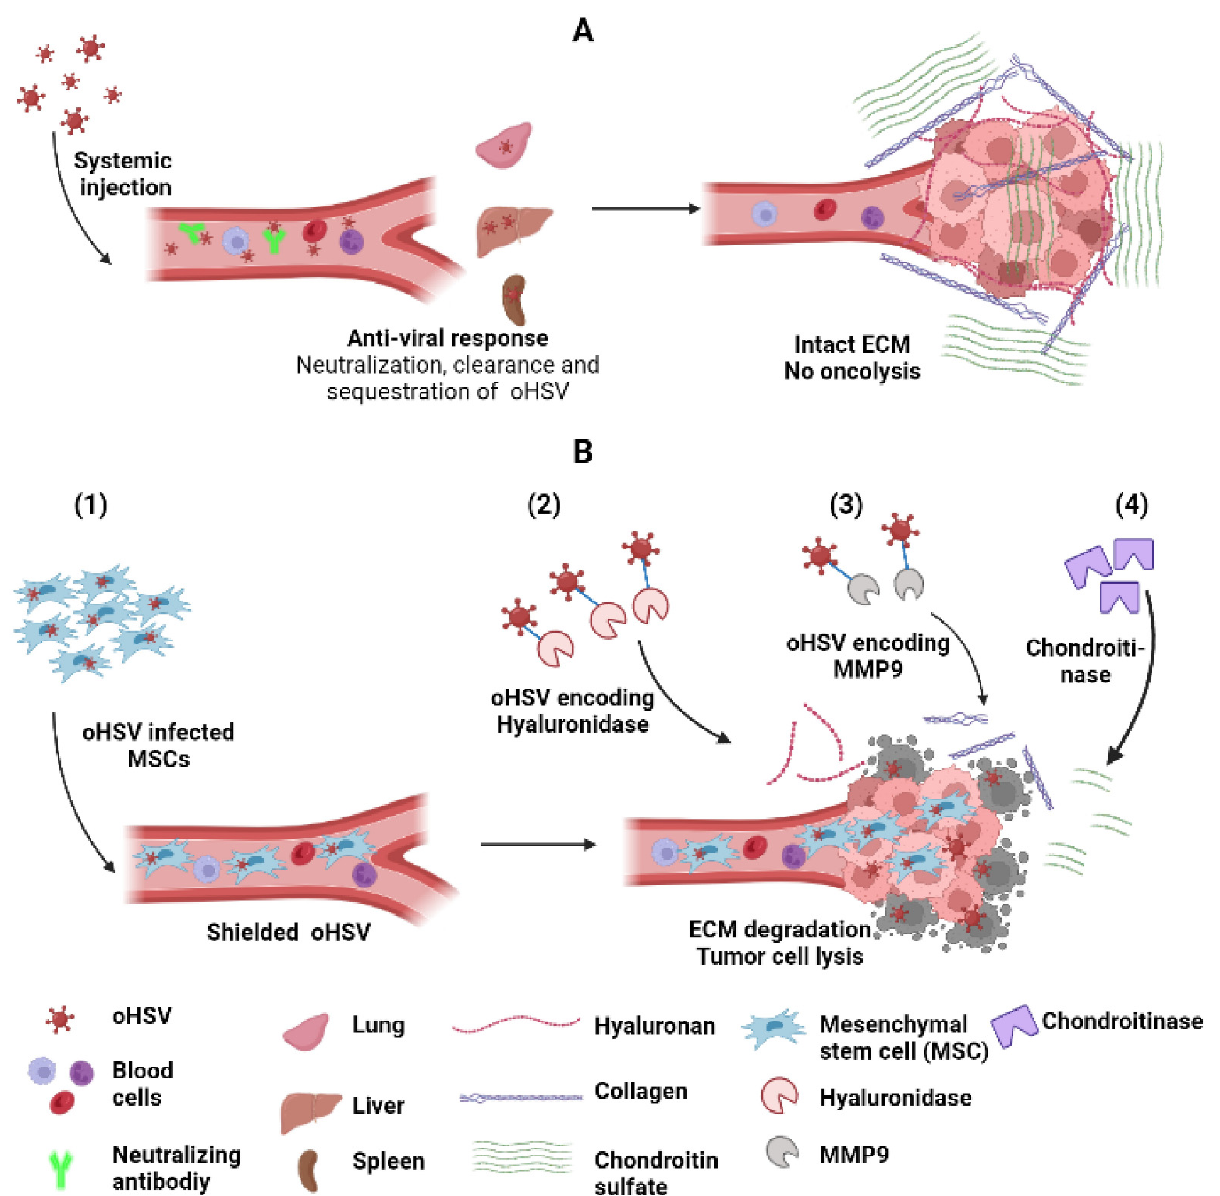
Figure 4. Strategies to improve systemic delivery and spread of oHSV. ( A ) Systemic delivery of oHSV to tumor cells is hampered by anti-viral response leading to neutralization by complement